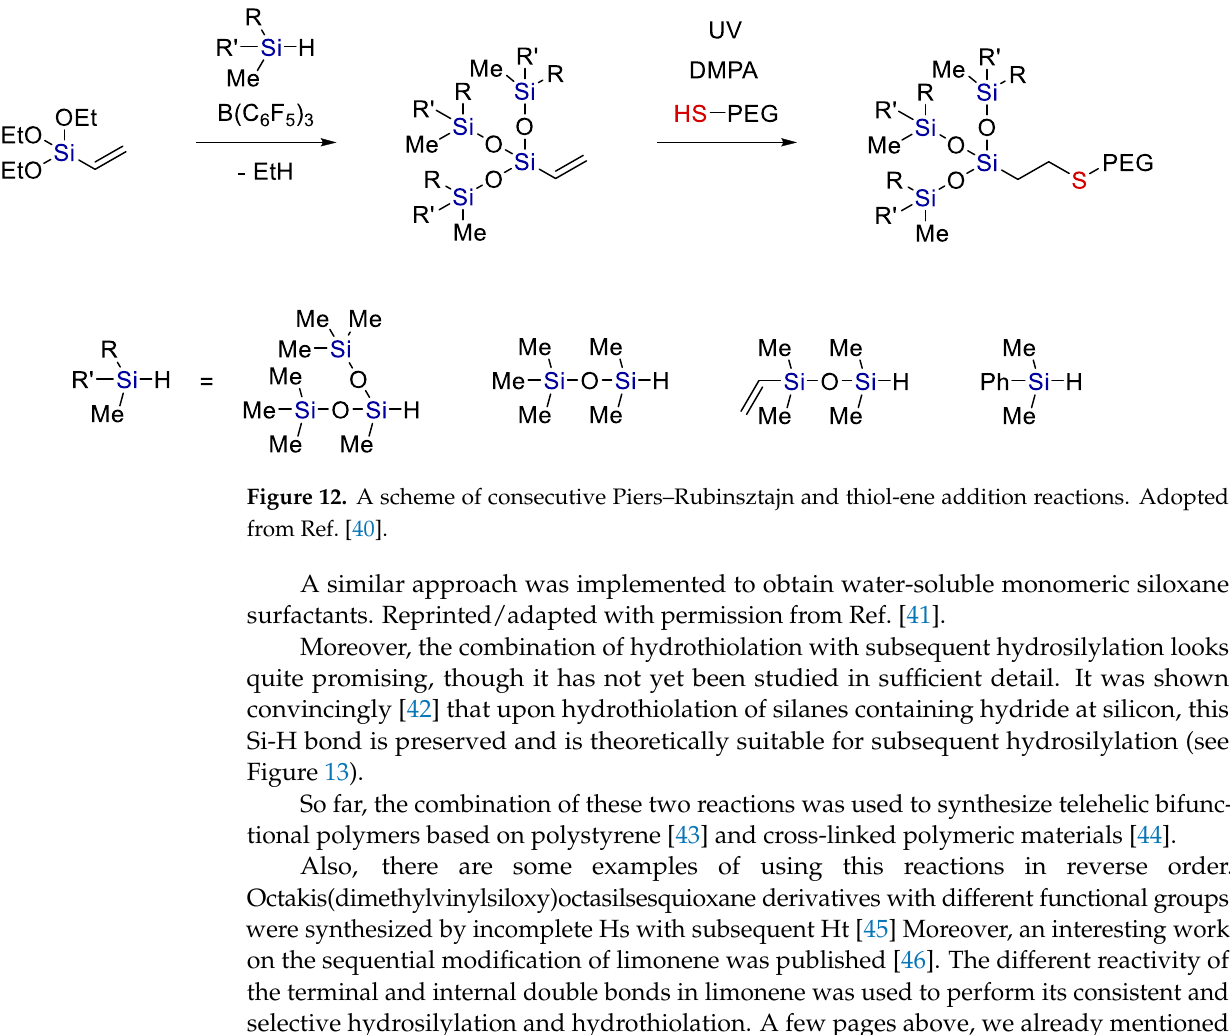
Figure 12. A scheme of consecutive Piers – Rubinsztajn and thiol-ene addition reactions [40].